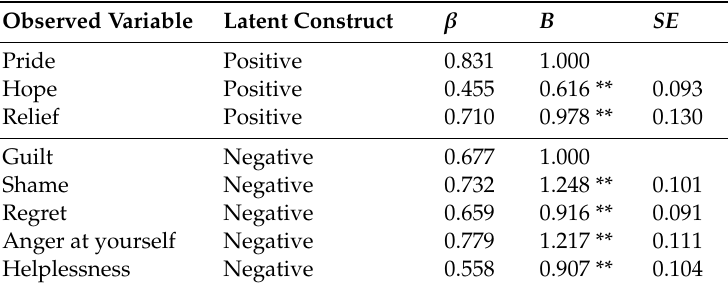
Table 6. Final CFA Results for Procrastination